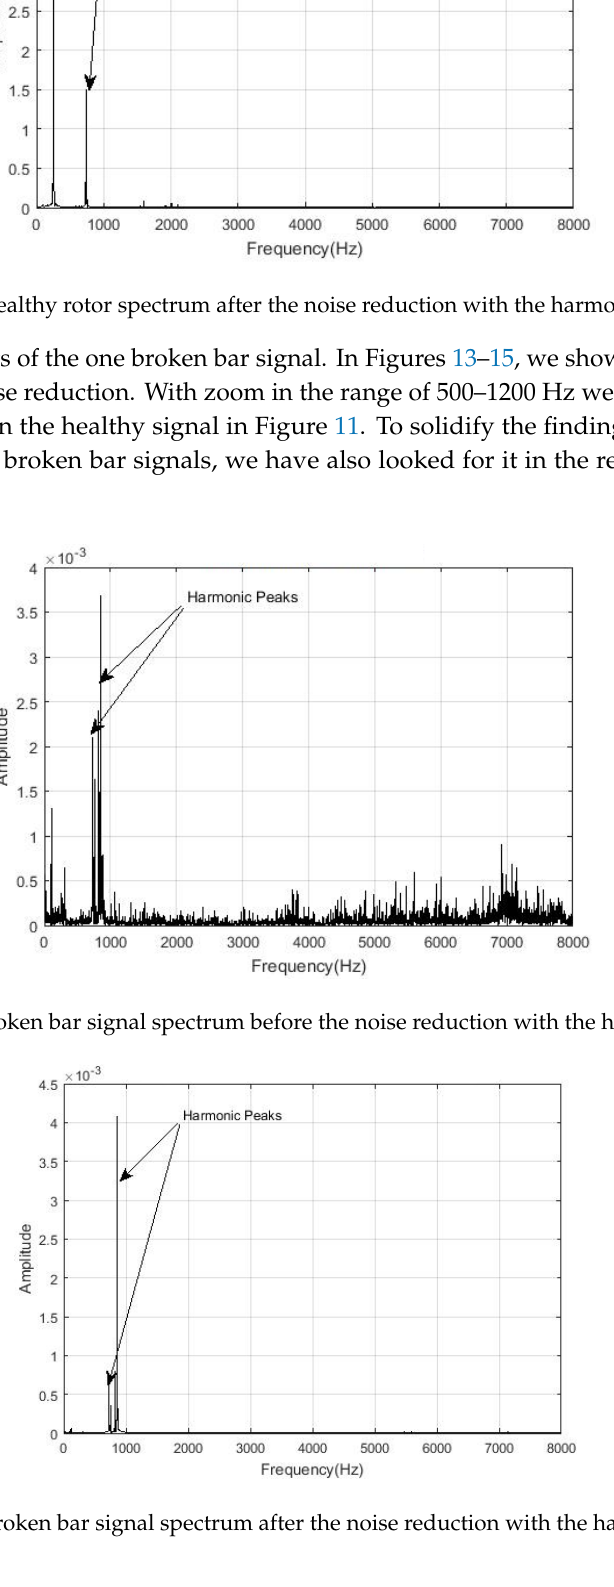
Figure 15. One broken bar signal spectrum before the noise reduction with zoom in the range of 500–1200 Hz. We show the spectrum results for the two broken bars signals in Figures 16–18. Regarding the spectrum of the signal with two broken bars in the relative position 1–2, we note four harmonic peaks, with different frequencies with respect to the healthy motor spectrum. Here, the most prominent harmonic amplitude is twice the highest of the previous signal (healthy and with one broken bar). The four harmonic pattern is also present in the signal corresponding to the two broken bars signals in relative positions 1–5, see Figure 16. However, in the spectrum of the two broken bars signals in relative positions 1–3, we only appreciate two peaks, see Figure 17.